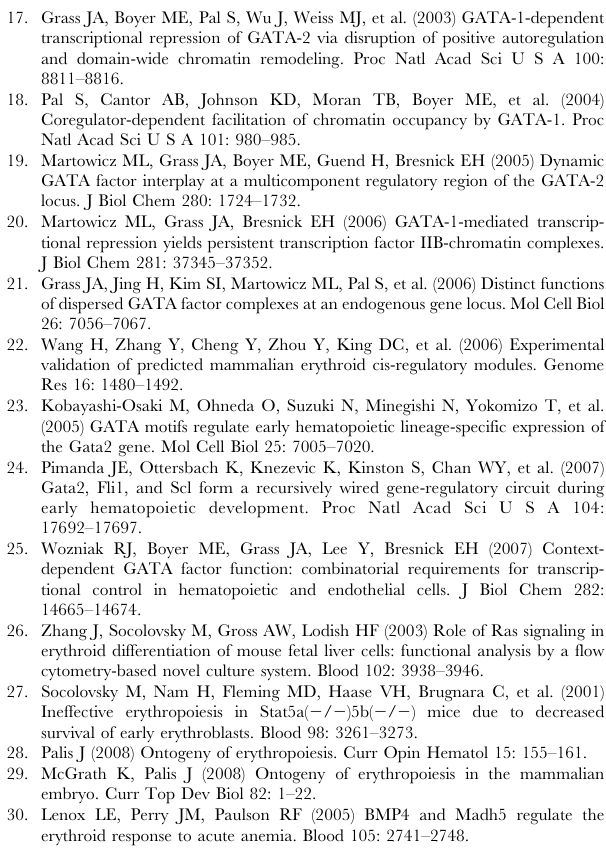
Figure S2 E12.5 hematopoiesis in D -1.8 mice. Representative E12.5 wildtype (WT) and D -1.8 embryos (A). Cytospins of embryonic peripheral blood and fetal liver cells from E12.5 WT and D -1.8 embryos (B). Number of CFU-GEMM, CFU-GM, BFU-E, and CFU-E colonies per 10 4 wild-type and D -1.8 E12.5 fetal liver cells (C). FACS histograms showing the proportion of wild-type and D -1.8 fetal livers (D). Figure S3 Loss of the 2 1.8 kb site leads to altered nucleoprotein architecture of the Gata2 locus. Quantitative ChIP analysis